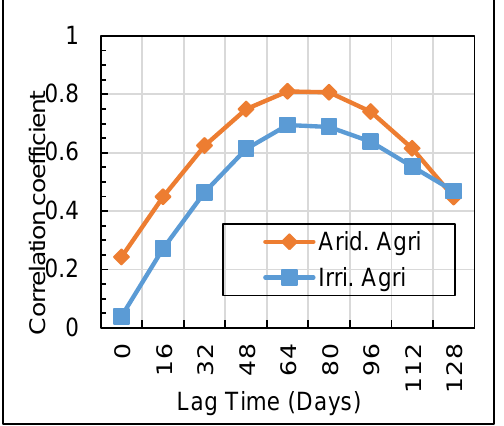
Figure S6. Moisture conditions and rainfall lag time relations in the Koshi River Basin.